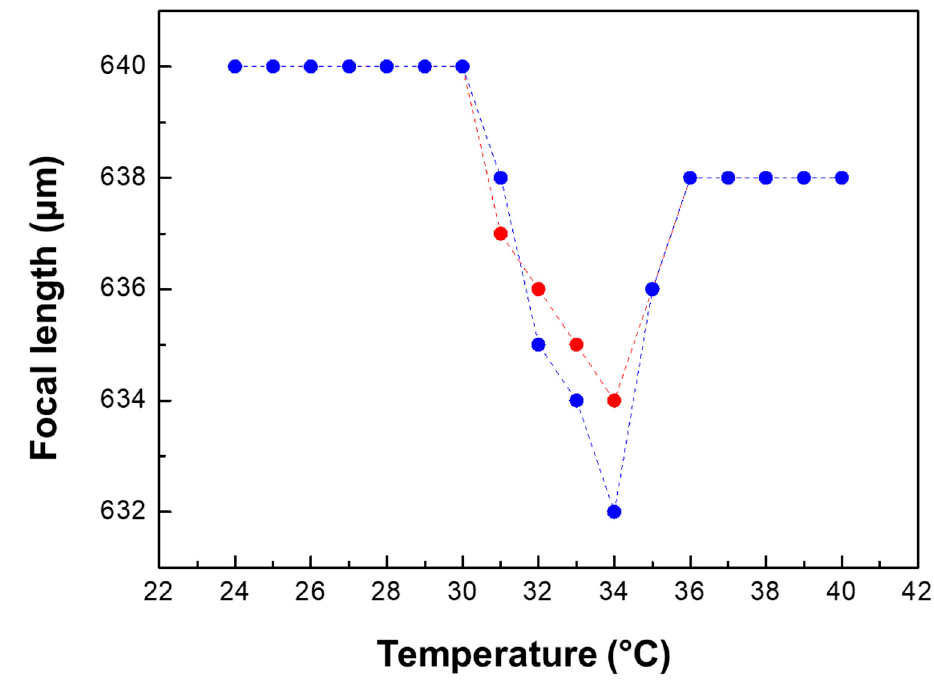
Figure 10. Focal length of the microlens array as a function of temperature. The red and blue dots represent the heating and cooling processes, respectively. The dashed line is used to describe the behavior of the focal length change.